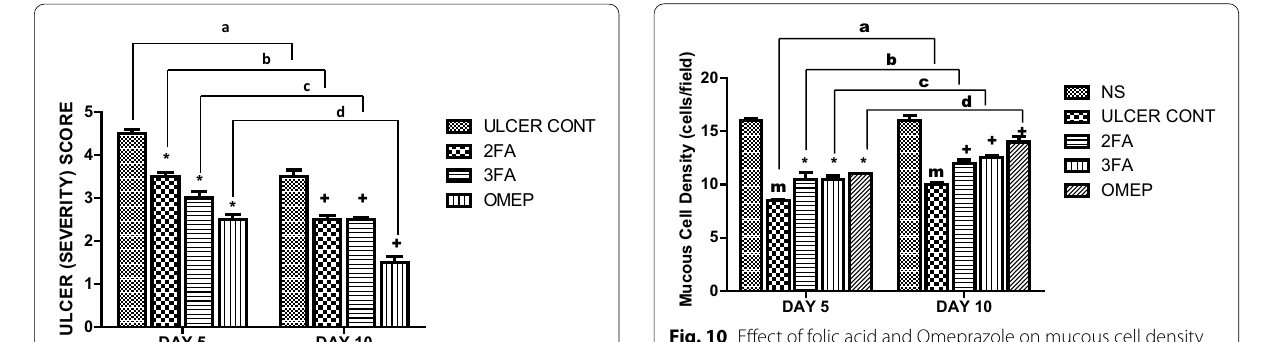
p < 0.05 cf. ulcer control, day +